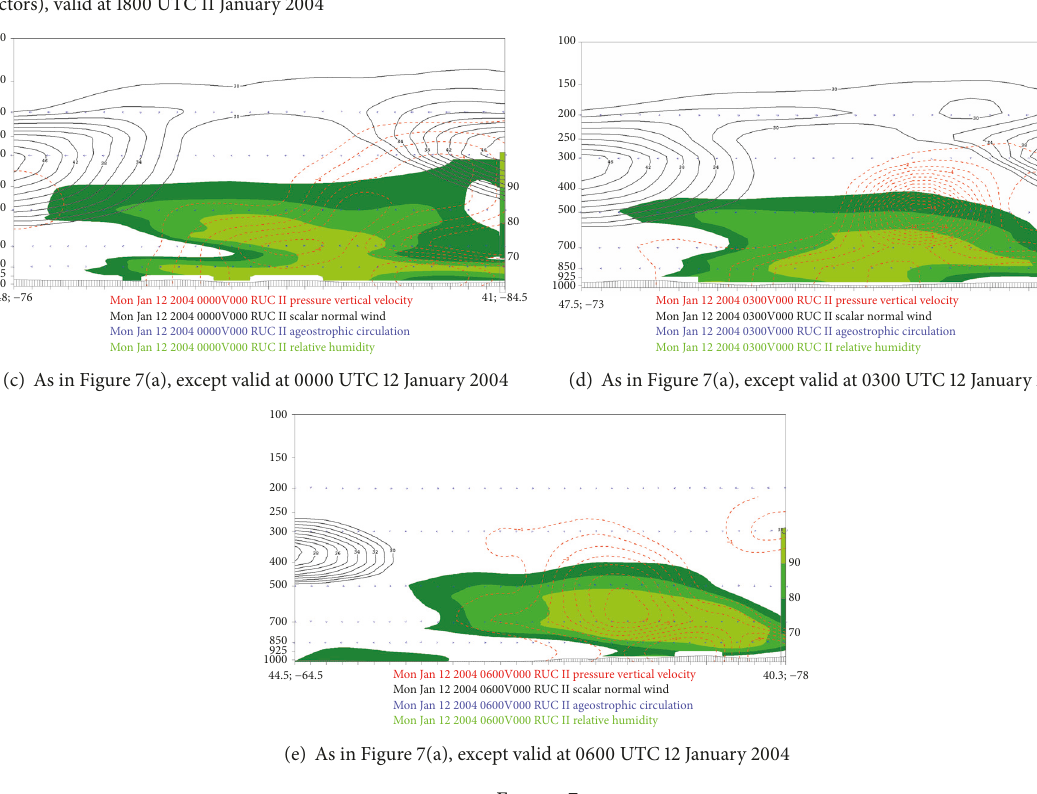
(e) As in Figure 7(a), except valid at 0600 UTC 12 January